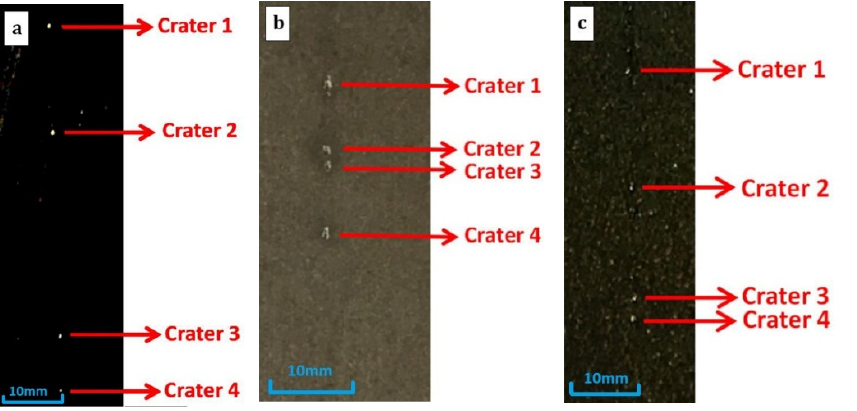
Figure 4. Craters on different surface: ( a ) Craters on a flat surface; ( b ) Craters on a trim surface; ( c ) Craters on a rough surface.